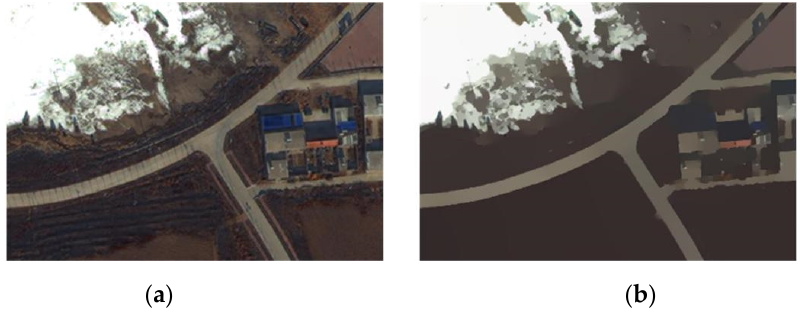
Figure 3. Comparison of the L0 filtering effect. ( a ) Original image; ( b ) after filtering.